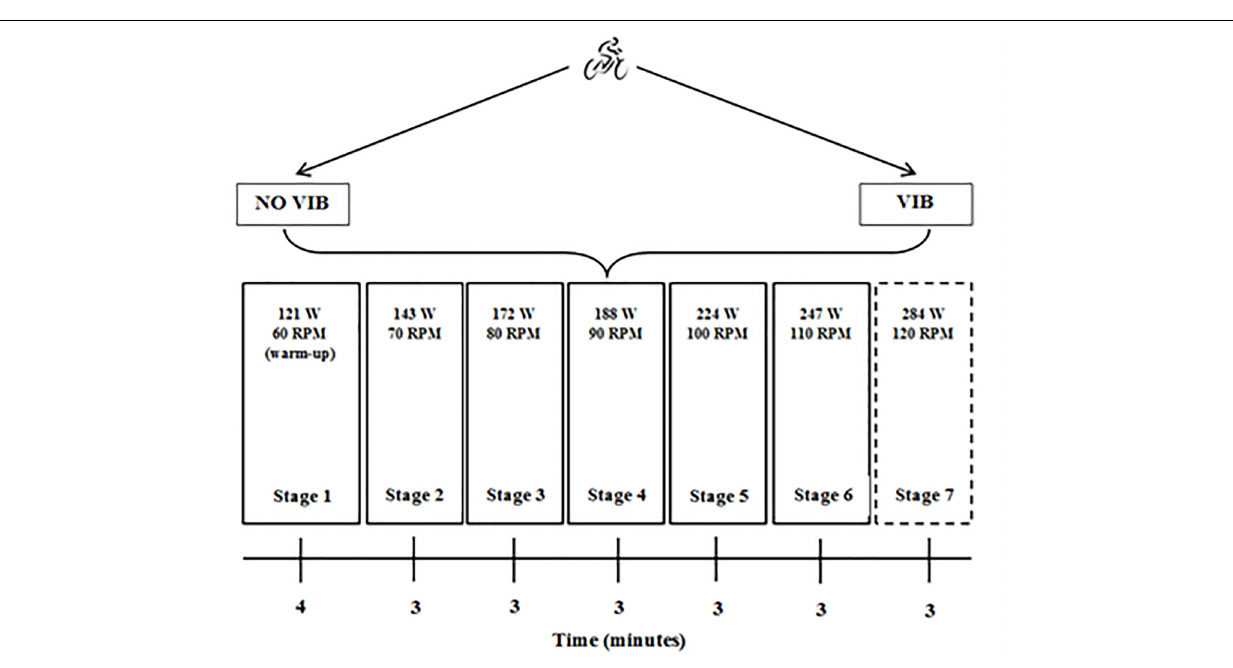
FIGURE 2 | Graded maximal cycling test protocols to assess VO 2 max with or without